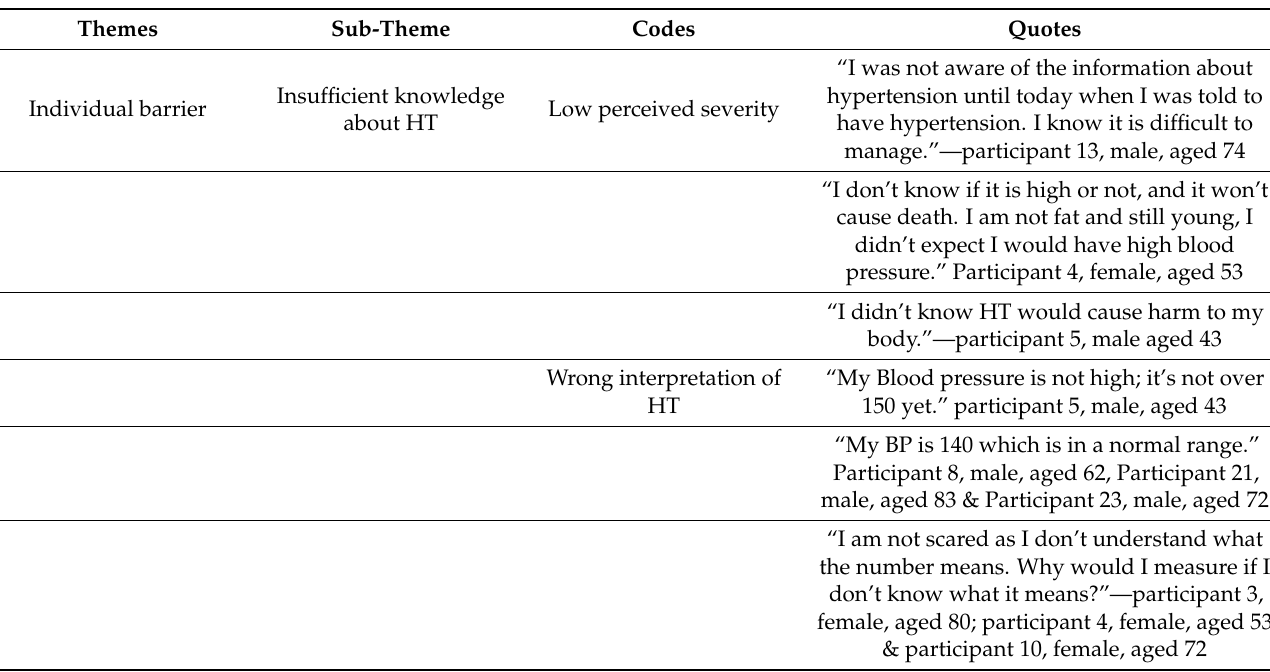
Table 3. Overview of the themes, sub-themes, codes and